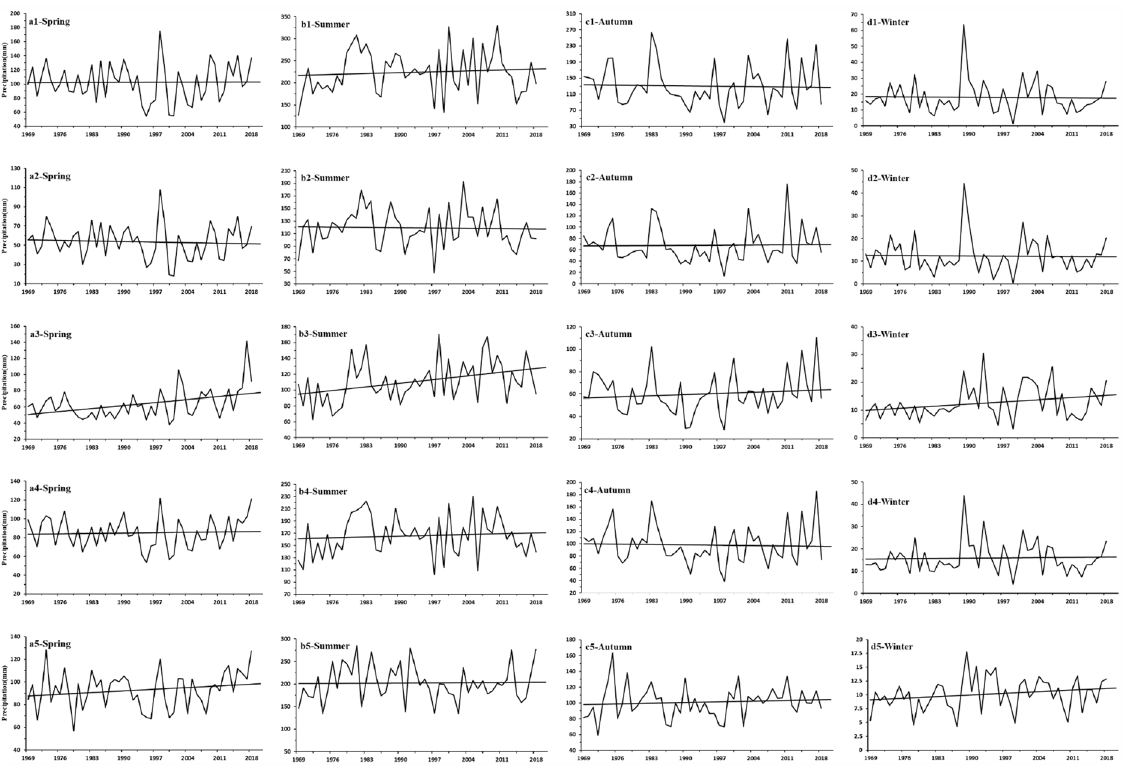
Figure 5. (From top to bottom) Variation in mean precipitation on the southern flank of the Qinling Mountains, the northern flank of the Qinling Mountains, the southern flank of the Daba Mountains,